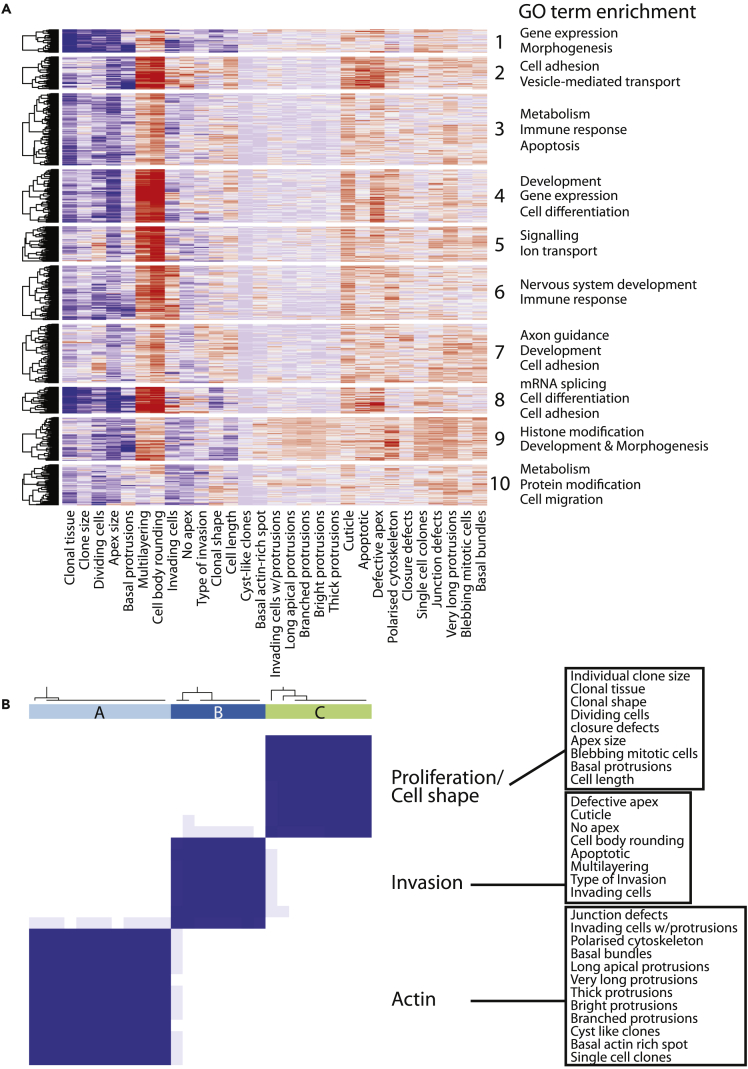
Clustering Analyses Identify 10 RNAi Line Clusters and Three Distinct Phenotypic Subgroups(A) Heatmap representation of supervised clustering of 764 RNAi lines with average phenotype scores. Each row represents an RNAi line; each column represents a phenotype category. A priori, the model-based optimal number of K = 10 (phenotypic clusters) was determined. The clustering of rows and columns are based on Euclidean distance. Map colors represent row-scaled average scores: blue indicates the lowest score, light blue indicates an intermediate score, and red indicates the highest score. Each cluster was analyzed with regard to biological function by GO enrichment analysis. The most enriched representative GO categories are shown on the right-hand side of each cluster.(B) Consensus clustering of average scores of 29 phenotypic categories reveals three distinct subgroups. Each column represents one phenotype. Heatmaps display consensus values between pairs of phenotypes by blue shading. High consensus corresponds to phenotypes that always occur in the same cluster and is shaded dark blue.See also Table S4 and Figure S3.